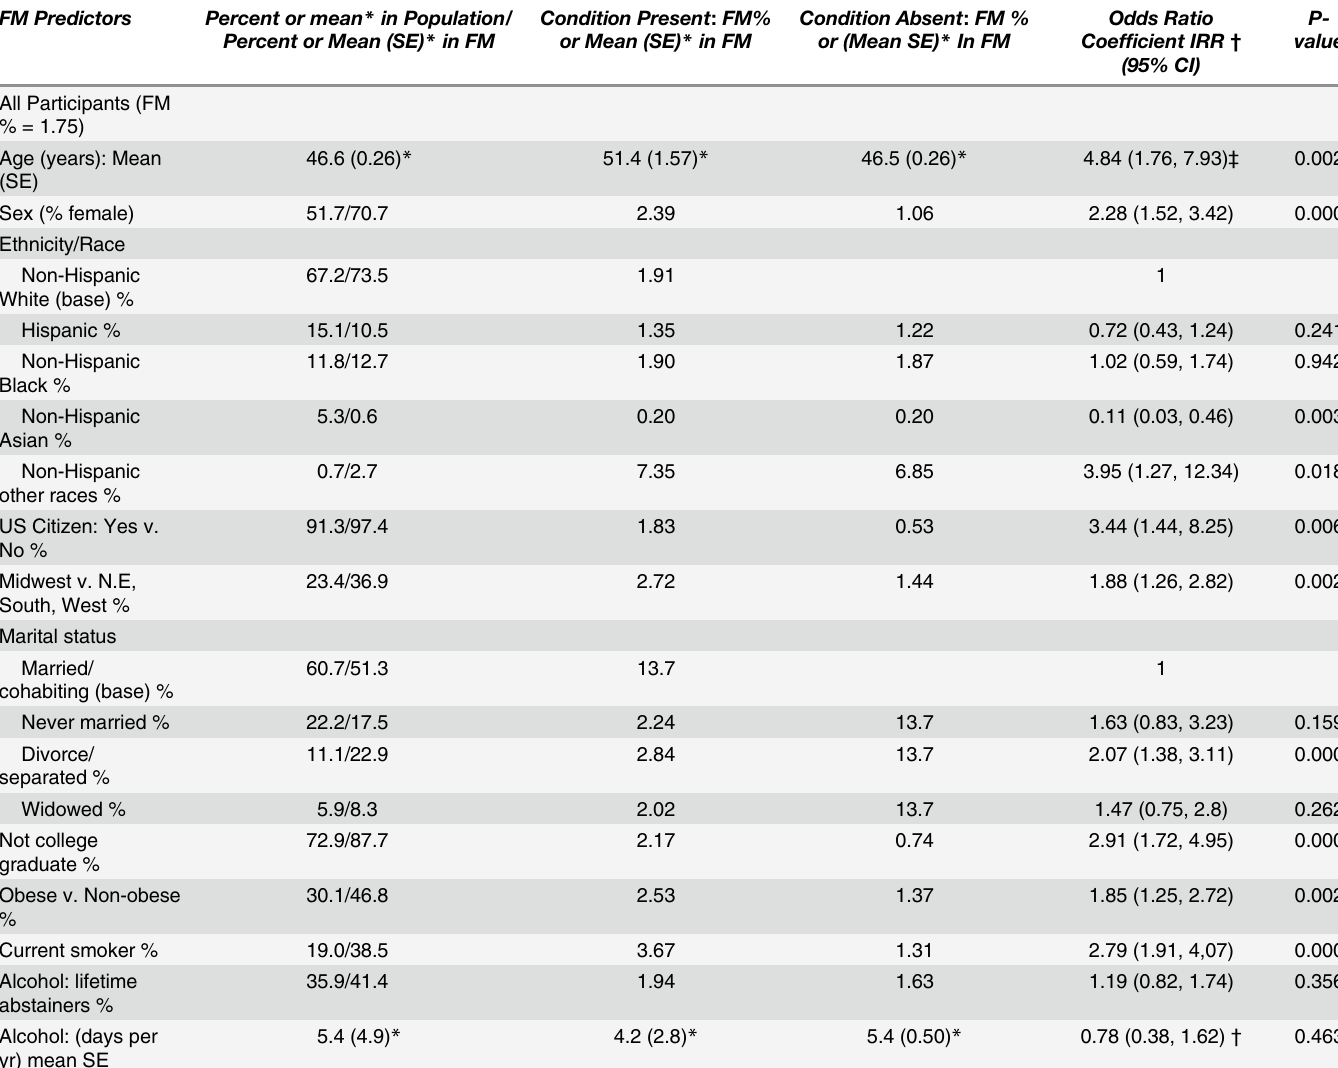
Table 2. Demographic characteristics of persons with and without fibromyalgia in the National Health Interview Survey (2012). FM Predictors Percent or mean * in Population/ Percent or Mean (SE) * in